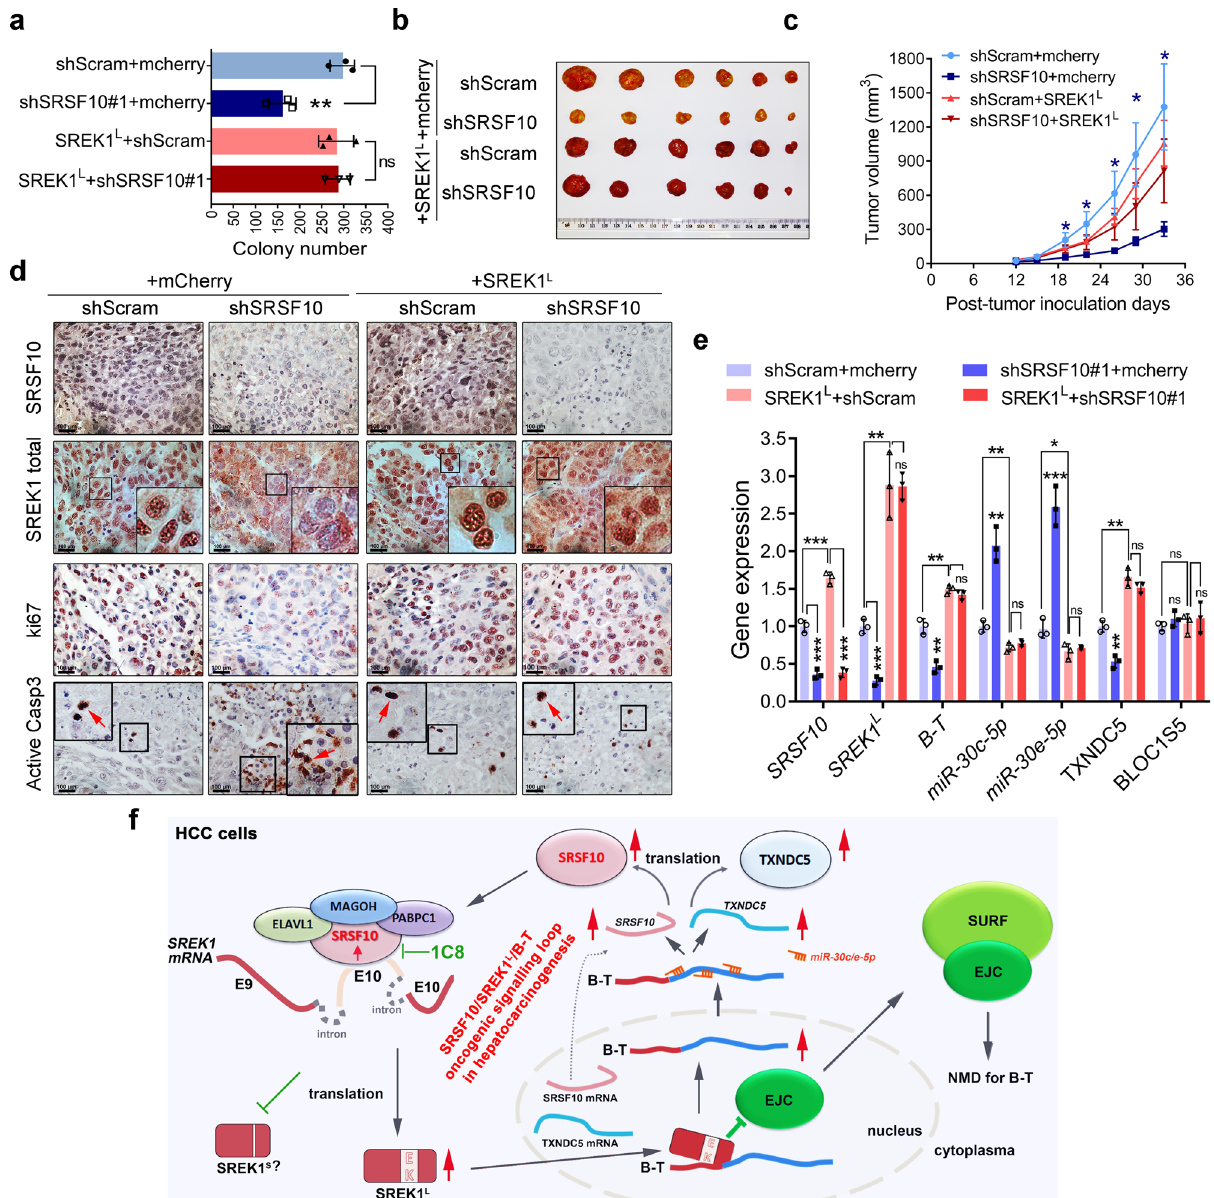
Fig. 8 SREK1 L is an oncogenic downstream effector of SRSF10 to promote the carcinogenesis of HCC cells, and the oncogenic SRSF10/SREK1 L /B-T signaling loop is crucial for hepatocarcinogenesis. a The quanti fi cation of anchorage-independent soft agar colony formation assays of stable knockdown of SRSF10 or the combination of the forced expression of SREK1 L in HCCLM3 cells ( n = 3, mean ± SD, two-tailed, unpaired t test is used, ** p < 0.01; ns non- signi fi cant). b The represented xenograft tumors and c mouse xenograft tumorigenic assays in stable SRSF10-knockdown, scramble-transfected HCCLM3 cells or stable SRSF10-knockdown HCCLM3 cells following SREK1 L re-expression ( n = 6, mean ± SEM, two-tailed, unpaired t test is used, * p < 0.05). d Immunohistochemical staining of HCCLM3 xenografts for SRSF10, SREK1, Ki-67 and active Caspase 3 (scale bar = 100 μ m). e A panel of genes expression in xenograft tumors evaluated by real-time PCR ( n = 3, mean ± SD, two-tailed, unpaired t test is used, * p < 0.05; ** p < 0.01; *** p < 0.001; ns non-signi fi cant). f A proposed regulatory model showing how the oncogenic SRSF10/SREK1 L /B-T signaling loop in HCC cells promoting hepatocarcinogenesis. Source data are provided as a Source Data fi